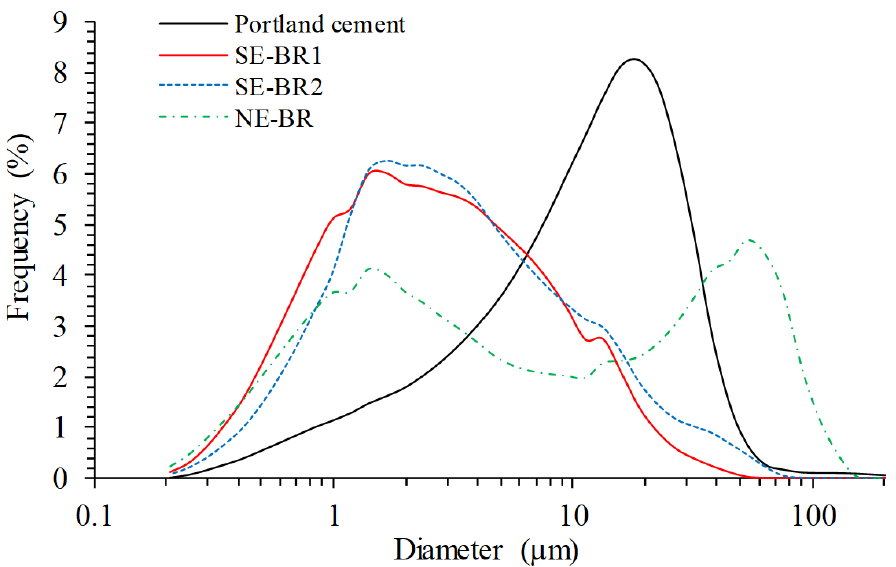
Figure 3 P article size distribution of cement and bauxite residues.